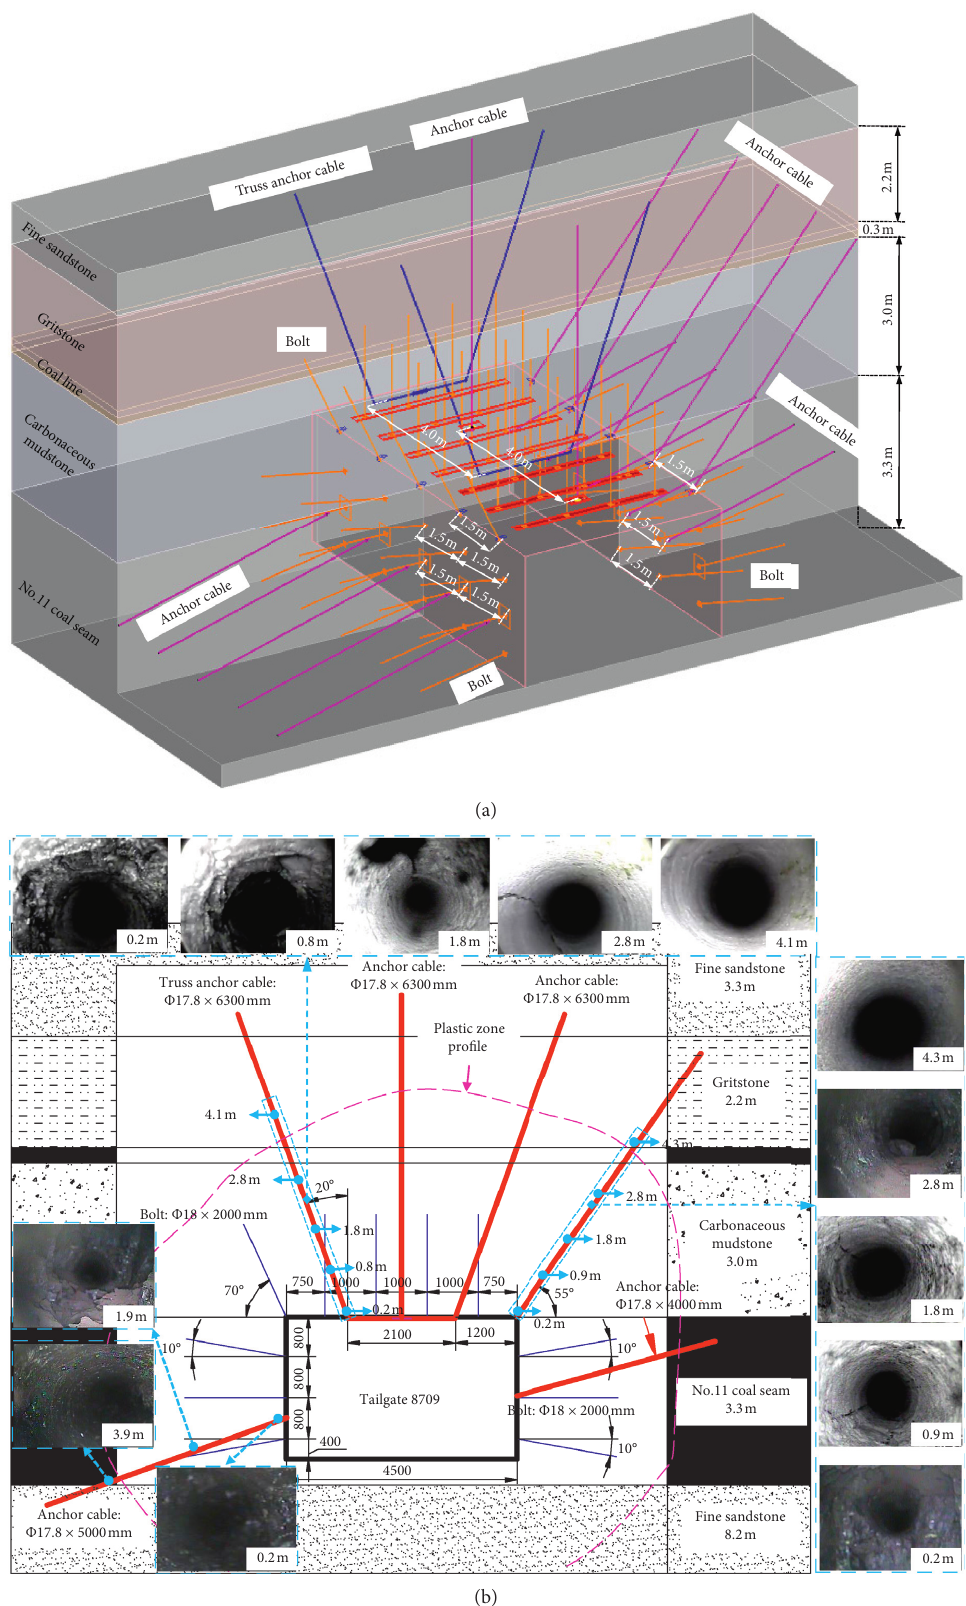
Figure 12: Support scheme of Tailgate 8709: (a) stereogram; (b) planar